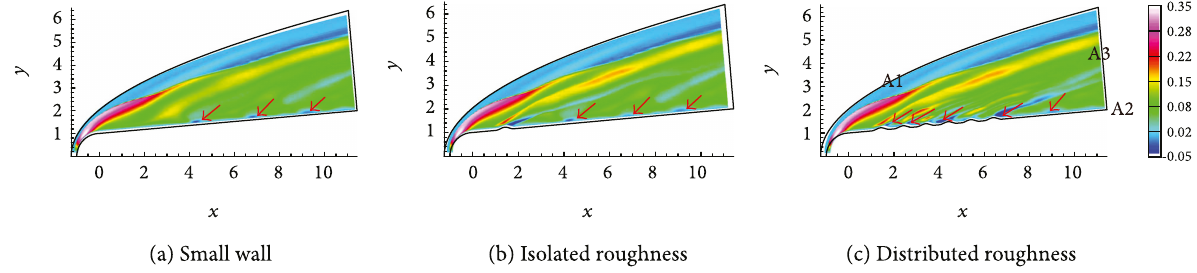
Figure 7: Contours of velocity along the y -axis under di ff erent